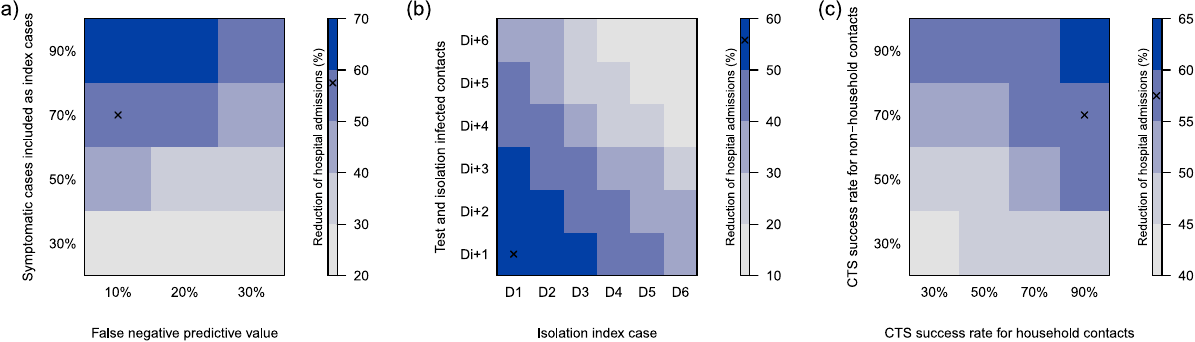
Fig. 4 Reduction of hospital admissions due to contact tracing according to the symptomatic cases included as an index case, the false-negative predictive value of testing, delays and the success rate of tracing, testing and isolating household and (non-)household contacts. Timings are expressed relative to symptom onset of the index case (D0), and days after testing the index case (e.g., Di + 1). All simulations start from the baseline scenario and assume a 50% and 30% reduction of B2B and community contacts, respectively, compared to pre-lockdown observations. The “ x ” marks the default settings, which are used if a parameter is not shown. CST contact tracing